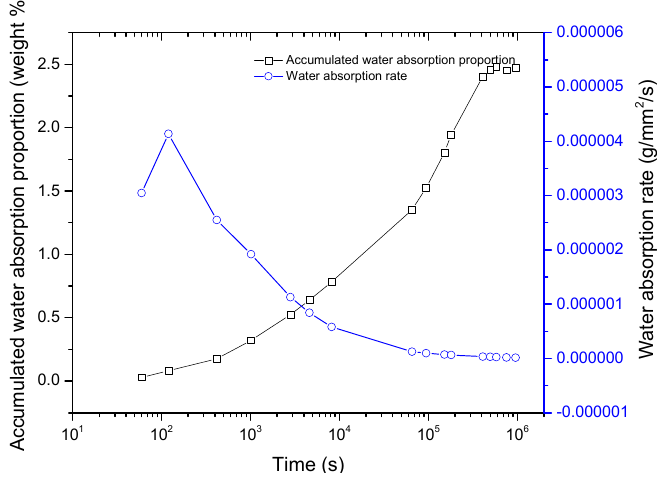
Figure 12. Sample water content during the whole experiment.